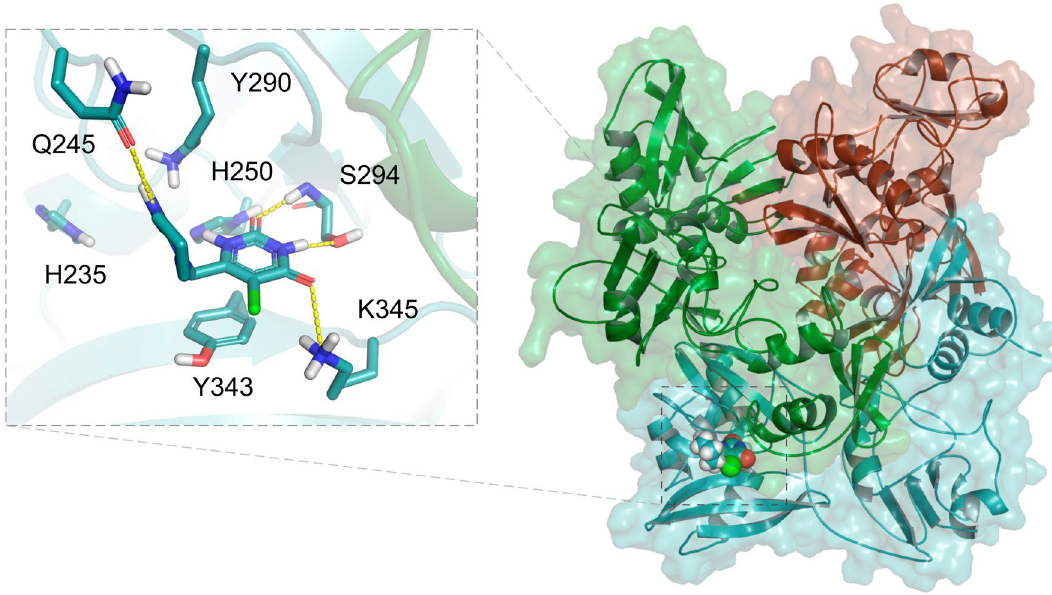
Figure 4. Structure of the Nsp15 trimer complexed with Tipiracil (PDB code 6WXC). The protein–ligand hydrogen bonds are represented as yellow dashed